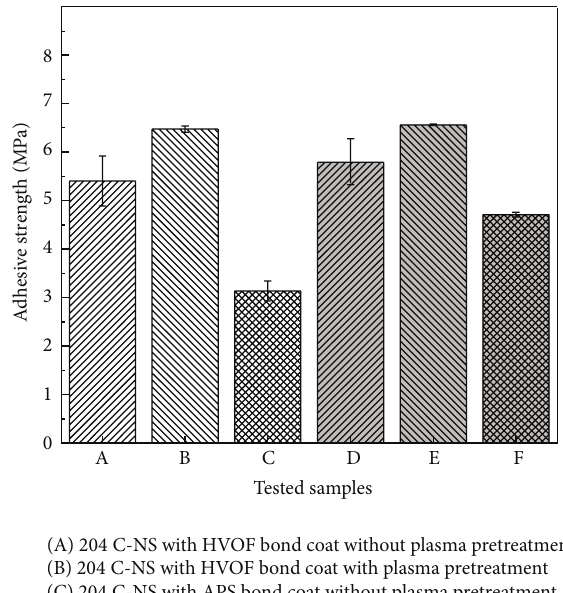
(A) 204 C-NS with HVOF bond coat without plasma pretreatment (B) 204 C-NS with HVOF bond coat with plasma pretreatment (C) 204 C-NS with APS bond coat without plasma pretreatment (D) 204 NS with HVOF bond coat without plasma pretreatment (E) 204 NS with HVOF bond coat with plasma pretreatment (F) 204 NS with APS bond coat without plasma pretreatment Figure 6: Adhesive strength values of as-prepared TBCs: (A) TBC- A, (B) TBC-B, (C) TBC-C, (D) TBC-D, (E) TBC-E, and (F)